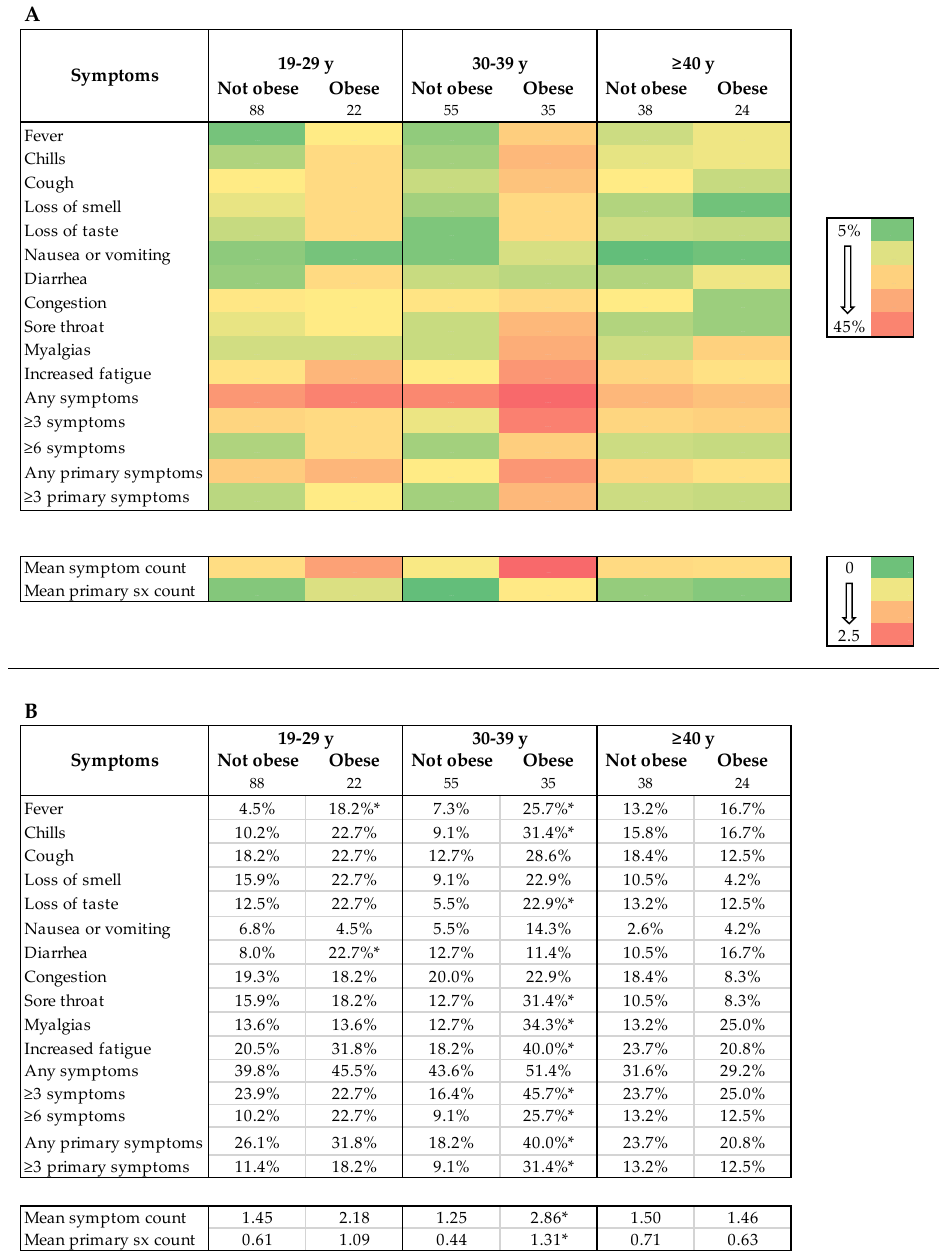
Figure 4. Symptom reporting by age group and obesity status among SARS-CoV-2 seropositive individuals. ( A ) Heatmap shows consistently higher symptom reporting amongst obese individuals in the 19–29 and 29–39 year age groups but not ≥ 40-year age group. Number of individuals in each category are listed below obesity markers. ( B ) Table lists relevant values. * indicates p < 0.05 for difference between obese and non-obese in that age category with Chi-squared test for proportions and ANOVA for test of mean.